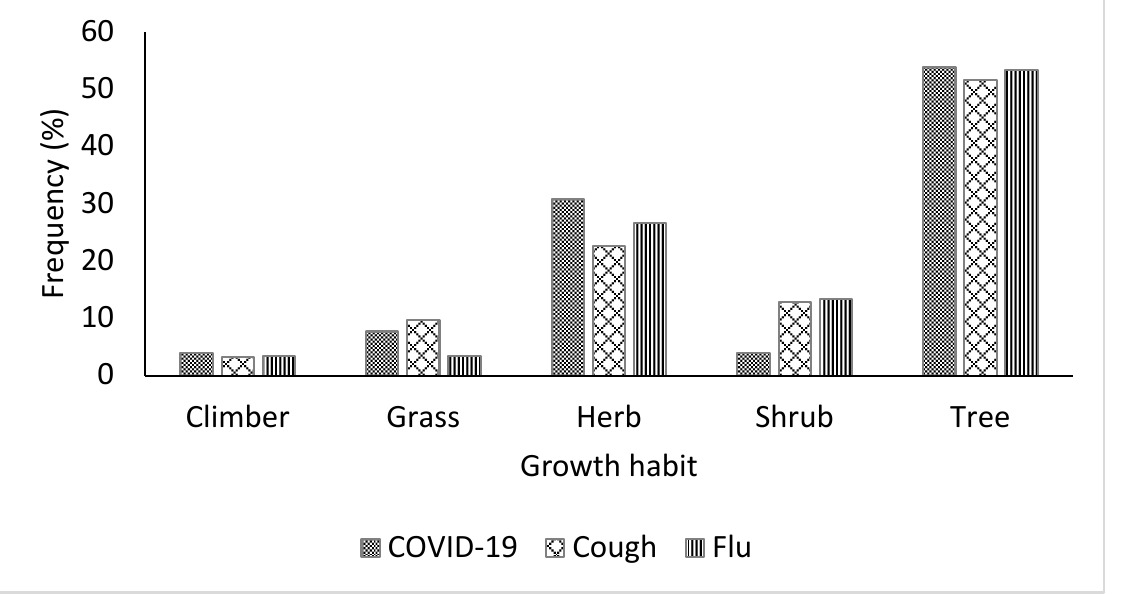
Figure 4. Growth forms of medicinal plants used for the treatment of COVID-19, cough, and flu in Ogbomosho North and South Local Government Areas, Oyo State, Nigeria.